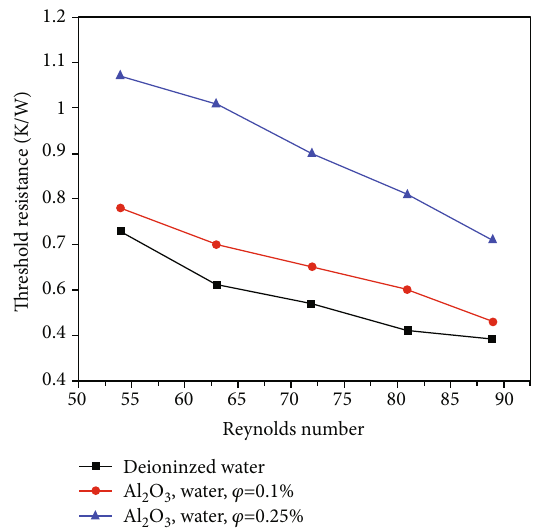
Figure 10: Thermal resistance vs. Reynolds number 15 W with heat input.